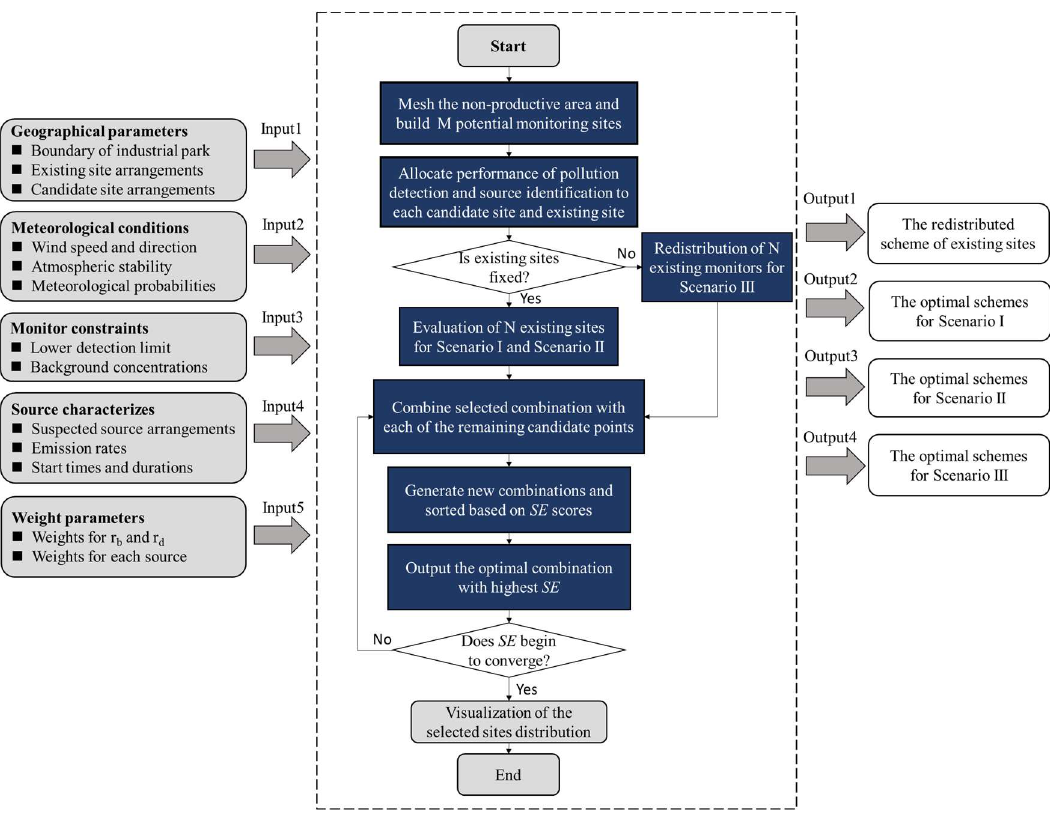
Figure 3. Flowchart of proposed method for optimal design of a dense AQMN.